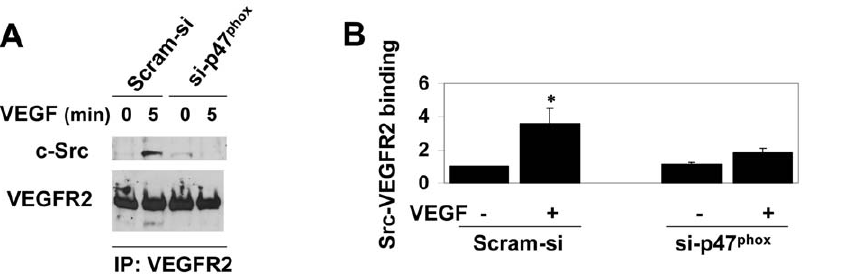
Figure 3. VEGF-induced interaction between VEGFR-2 and c-Src requires NADPH oxidase-derived ROS. (A) Co-immunoprecipitation (co-IP) assay using 1.2 mg protein lysates of HCAEC that were transfected with Scram-si or si-p47 phox and treated without or with VEGF (50 ng/ml for 5 min). IP was carried out using anti-VEGFR-2 antibody followed by immunoblotting using anti-c-Src (upper panel) and anti-VEGFR-2 (lower panel) antibodies. (B) Quantitative analyses of VEGFR-2-bound c-Src. Bar graphs show quantitative densitometric analysis of three independent experiments using NIH image J (-fold change expressed in mean 6 S.E.M.). * p , 0.05 was considered statistically significant.